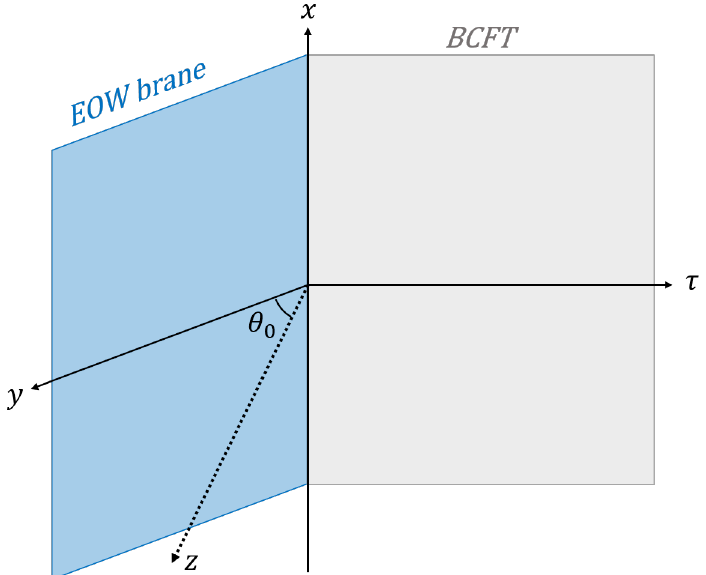
Figure 7. Holographic dual of a Euclidean BCFT defined on half spacetime ( τ > 0 ). Note that τ and x coordinates are exchanged, which is different from the common